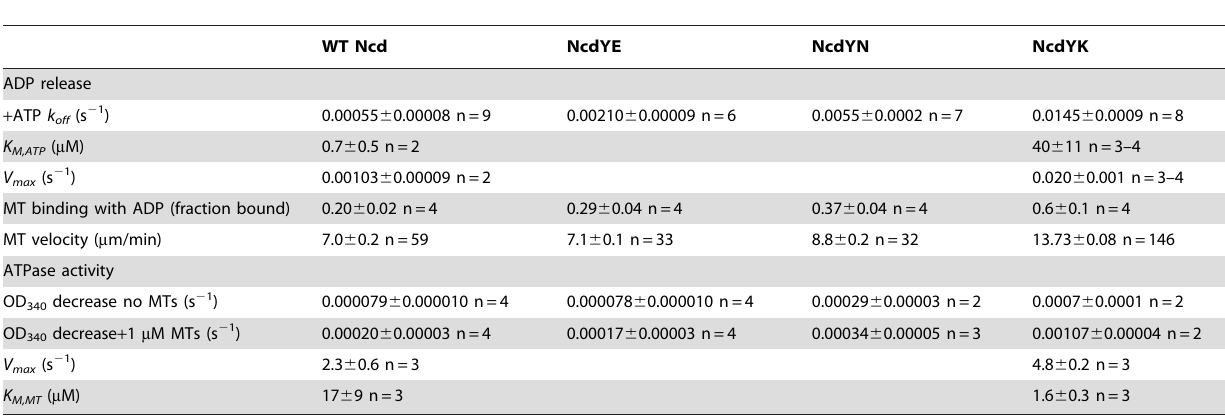
Table 1. NcdY485 kinetic